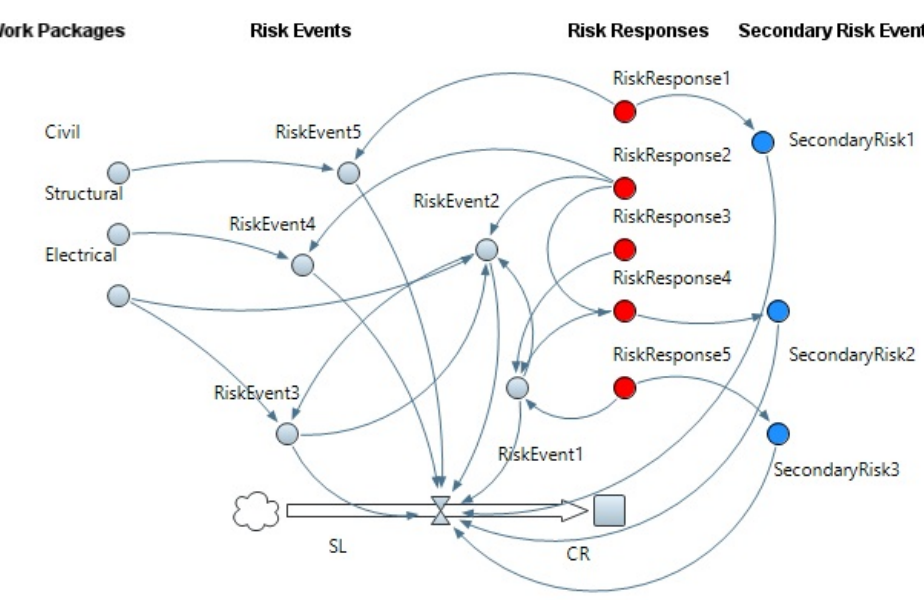
Figure 3. Graphical representation of FSD model in qualitative step in Anylogic software.